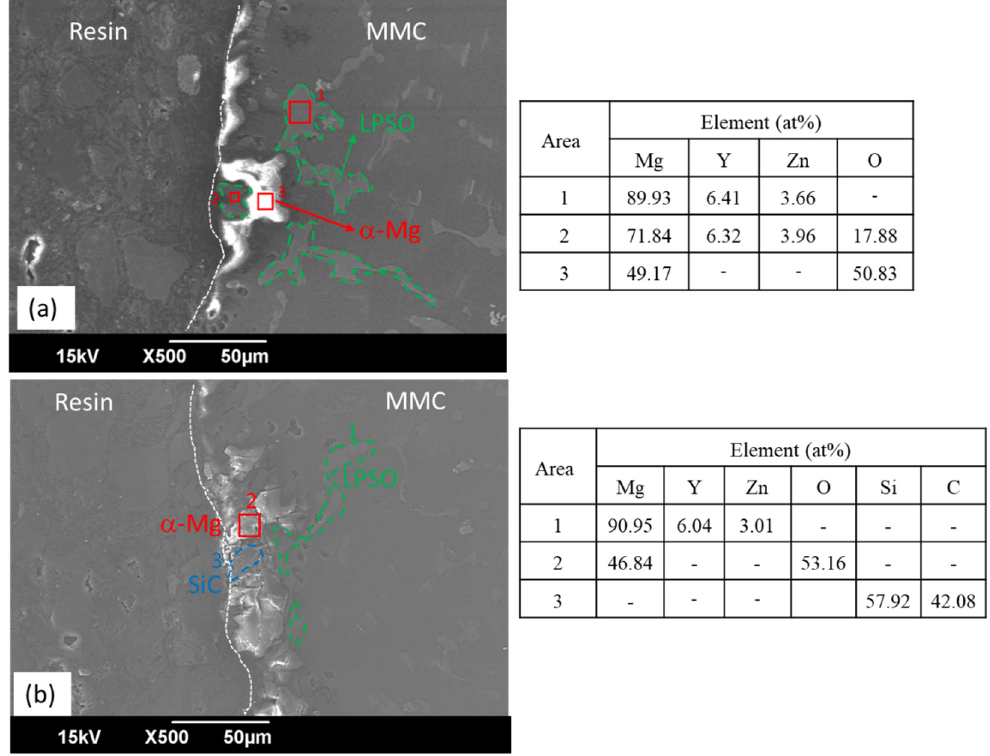
Figure 10. Cross section of MMC after immersion test showing corrosion in the selected regions: ( a ) α -Mg matrix/LPSO region; ( b ) α -Mg matrix/SiC region.